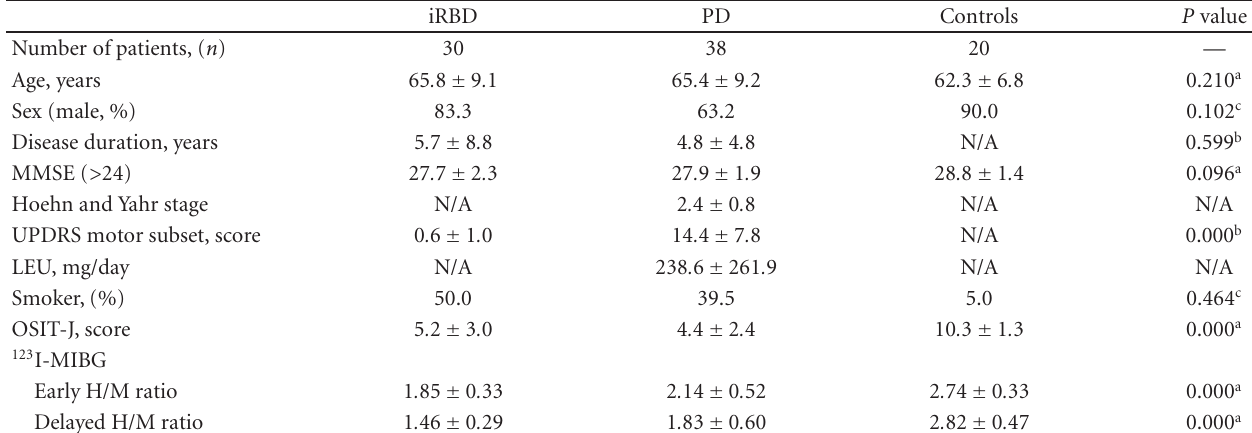
Table 1: Clinical characteristics of patients in the iRBD, PD, and control